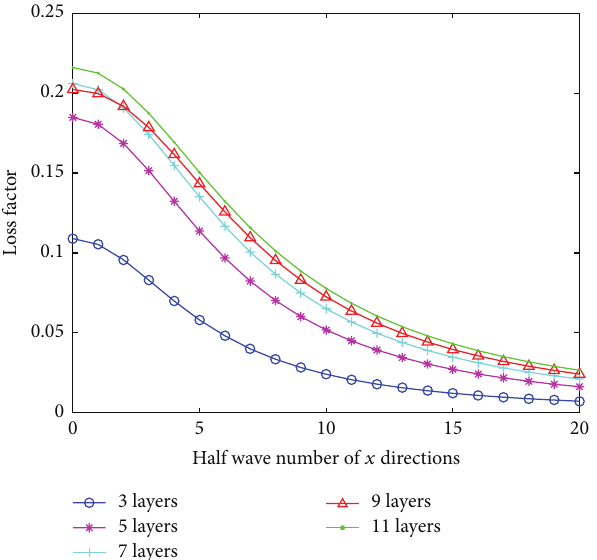
Figure 10: The loss factor of constrained damping plate with various layers ( 𝑛 = 10